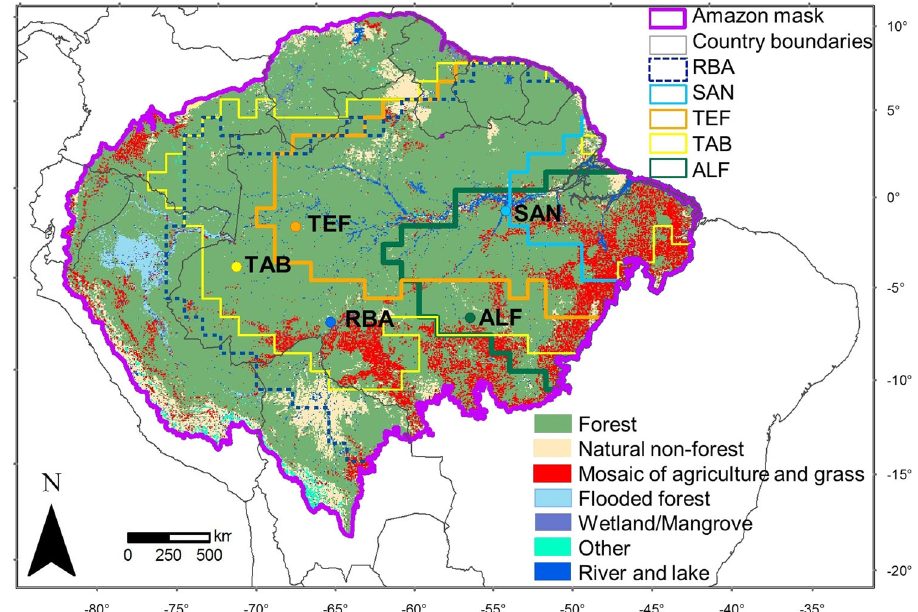
Fig. 1 Regions of in fl uence and land use and cover. Mean annual regions of in fl uence (2010 – 2018) for ALF (8.8°S, 56.7°W; green), SAN (2.8°S, 54.9°W; light blue), RBA (9.3°S, 67.6°W; dark blue), TAB (5.9°S, 70.0°W; yellow) and TEF (3.7°S, 66.5°W; orange) inside the Amazonian mask 50 (purple). Coloured circles indicate the aircraft sampling sites, and coloured lines represent 97.5% of the terrestrial regions of in fl uence associated with each site. Land use and cover data are from Mapbiomas 32 for Pan-Amazonia up to 2018; wetlands and other inland waters are not well